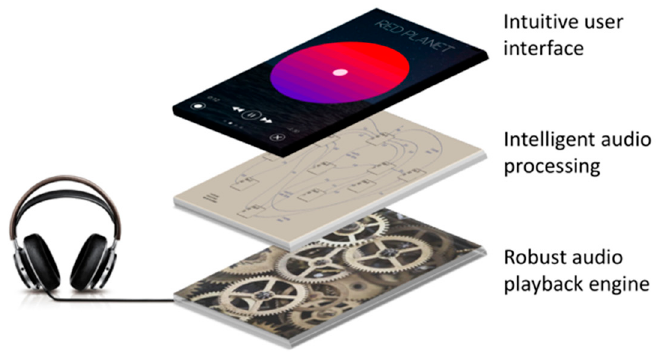
Figure 6. variPlay app architecture.